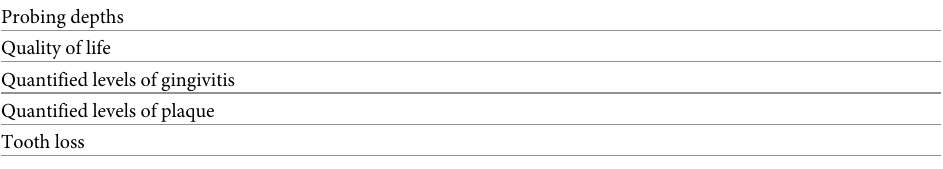
Table 4. Final core outcome set for effectiveness trials investigating the prevention and management of periodon- tal